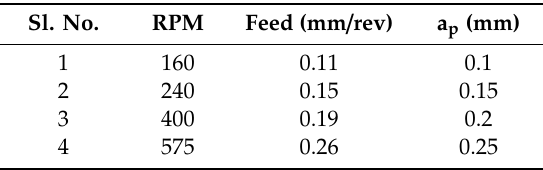
Table 1. Turning parameters and their